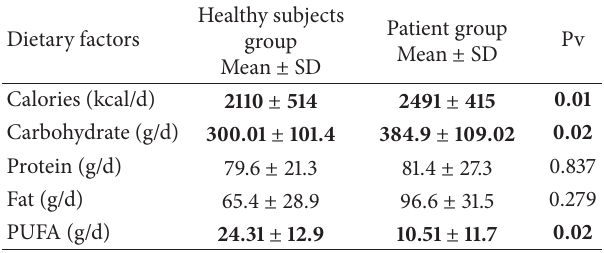
Table1:Nutrientintakesofhealthygroupandpatientgroupperday.